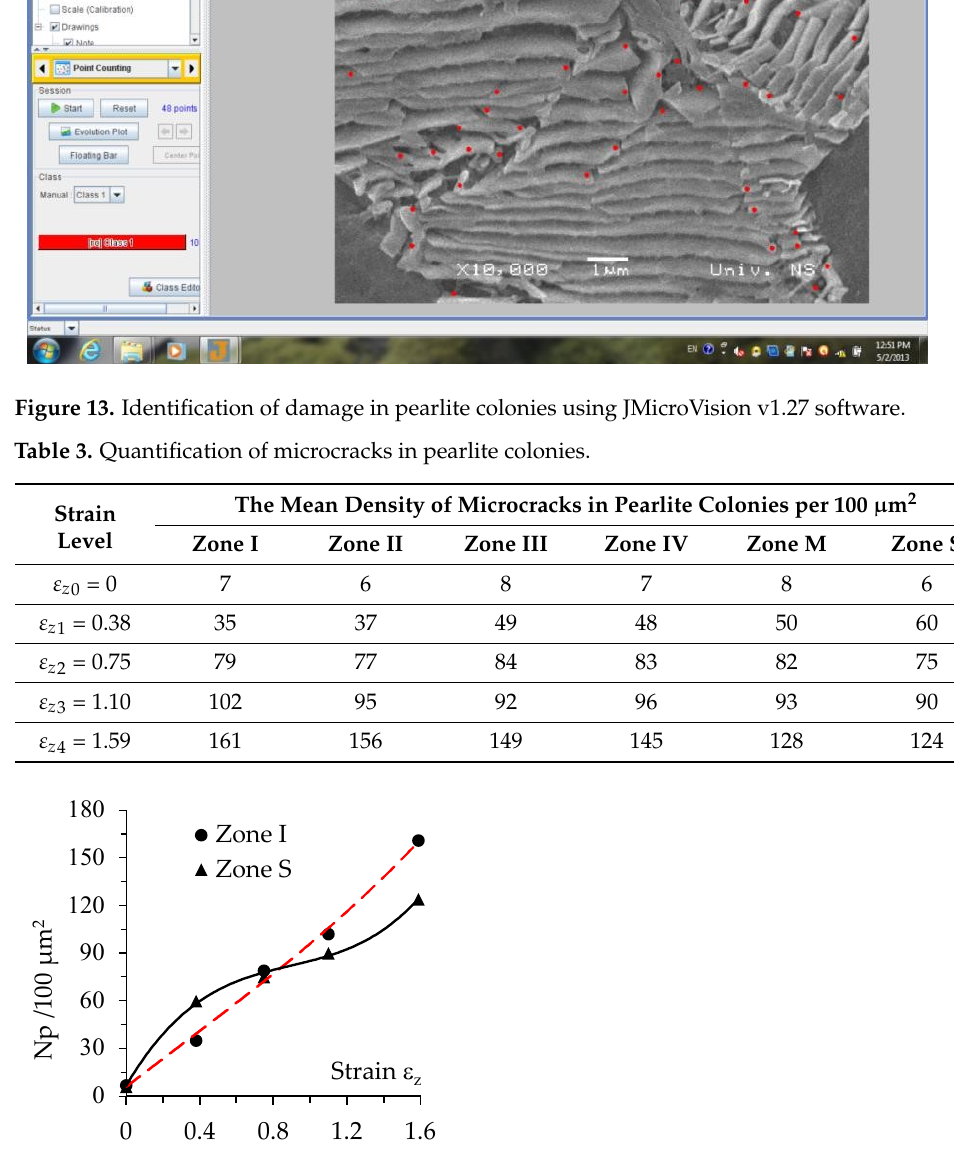
Figure 14. Density of microcracks in pearlite colonies for Zone 1 and Zone S.